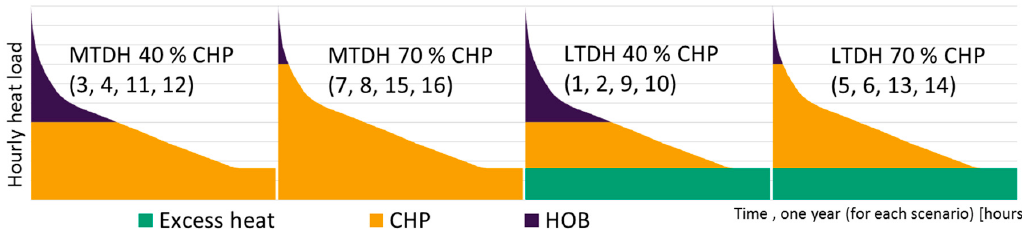
Figure 2. Heat load diagrams (where the hourly load over the period of one year is shown with the greatest load to the left and the smallest one to the right, for each scenario) of four different combinations of combined heat and power (CHP) percentages and low temperature district heating (LTDH) with excess heat. The scenarios corresponding to the respective combinations are in brackets.